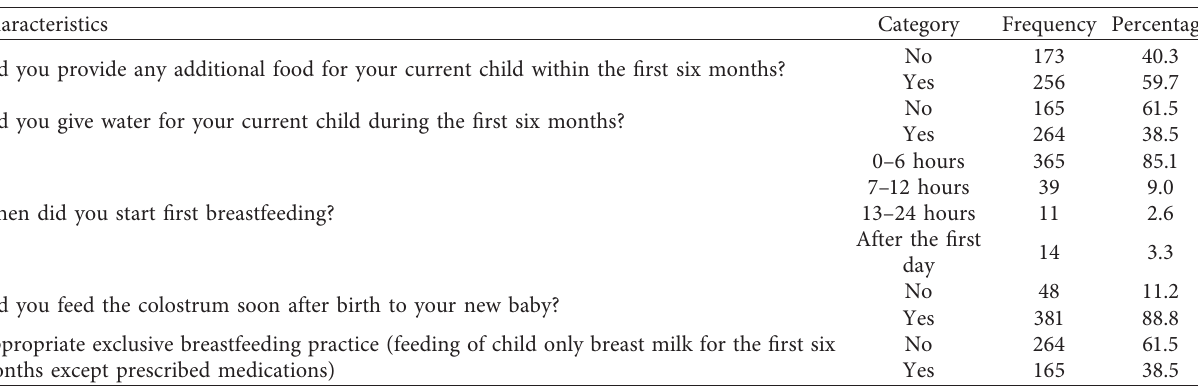
Table 4: Practice of employed mothers towards exclusive breastfeeding in Mecha district, Northwest Ethiopia, 2019 ( n � 429). Characteristics